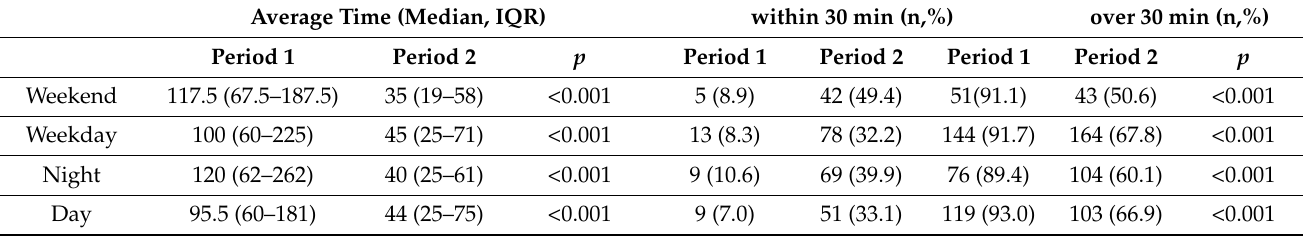
Table 3. Decision to incision time interval by time and day of the week.